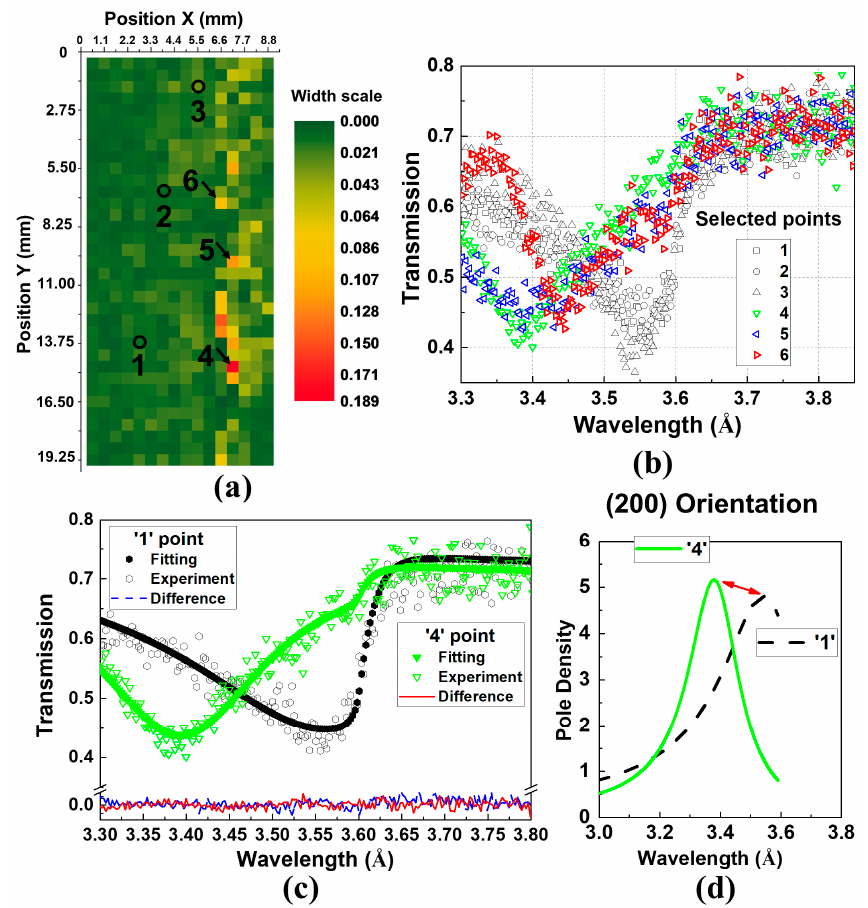
Figure 9. ( a ) Distribution of the (200) Bragg edge width ( σ 200 ) determined by iBeatles fitting. The mapping was conducted over the sample area of 19.25 × 8.80 mm 2 and the value in each data point is based on a spectrum obtained by applying a 10 × 10 pixel binning. ( b ) Transmission spectra selected from the data points in ( a ), denoted by arrows and circles. ( c ) Fitting transmission spectra calculated by Bragg-edge modeling, and ( d ) distribution of the crystallite orientation P ( α → (200) grains as a function of wavelength extracted from the modeling results in ( c ).